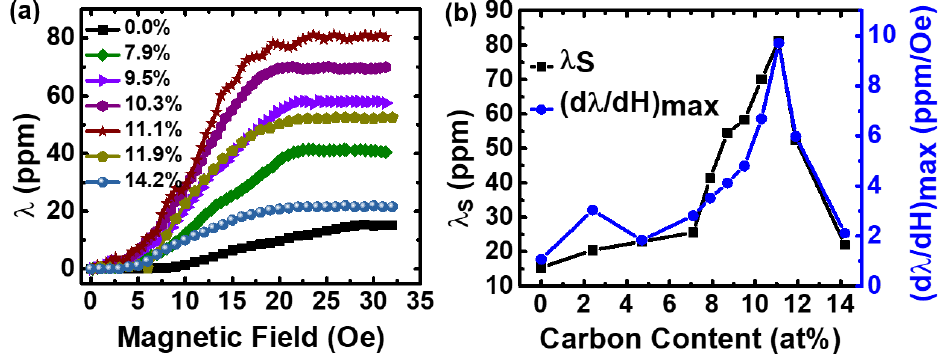
Figure 12. ( a ) Magnetostriction constant of Fe-Ga-C. ( b ) Saturation magnetostriction constant and maximum piezomagnetic coefficient of Fe-Ga-C. Reproduced with permission from [61]. Copyright [2019], IEEE.